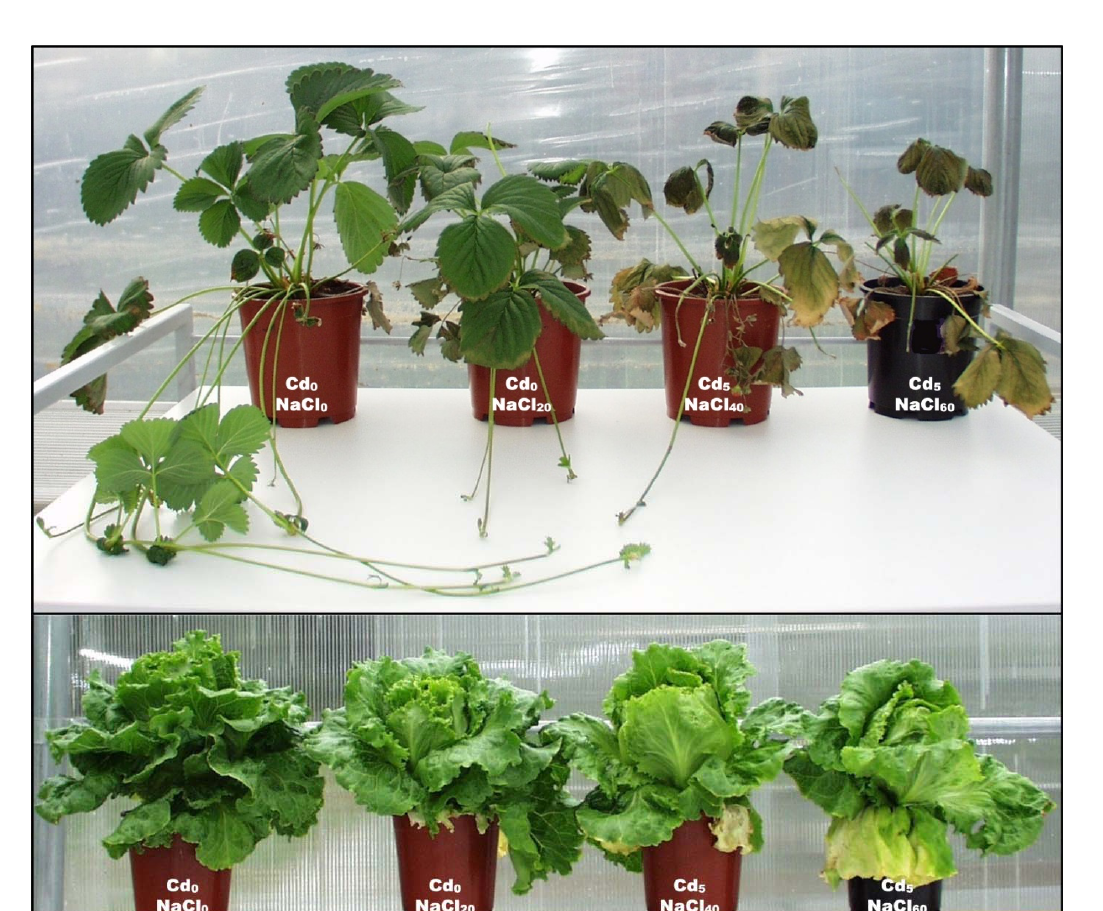
Figure 1. Impact of selected treatments (from left to right: Control—Cd 0 xNaCl 0 ; Cd 0 xNaCl 20 ; Cd 5 xNaCl 40 ; Cd 5 xNaCl 60 ) on growth of strawberry (70 days after salinity treatment commenced (DASAL)) and lettuce (30 DASAL).